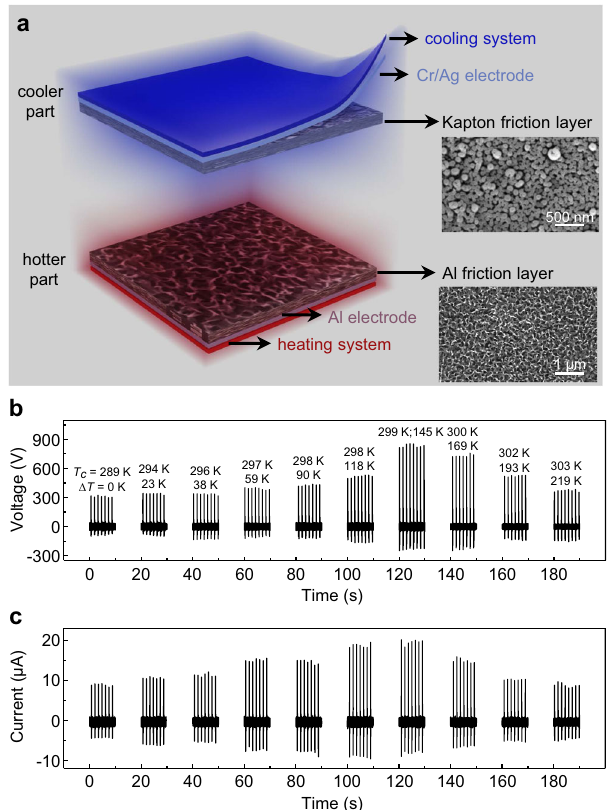
Fig. 2 Design and output performance of temperature difference TENG with controllable friction layer temperature (TDNG). a Schematic diagram of TDNG. Insets are scanning electron microscope images of nanostructures on Kapton (scale bar: 500 nm) and Al (scale bar: 1 μ m). b The open-circuit voltage of TDNG under different Δ T . c The short-circuit current of TDNG under different Δ T